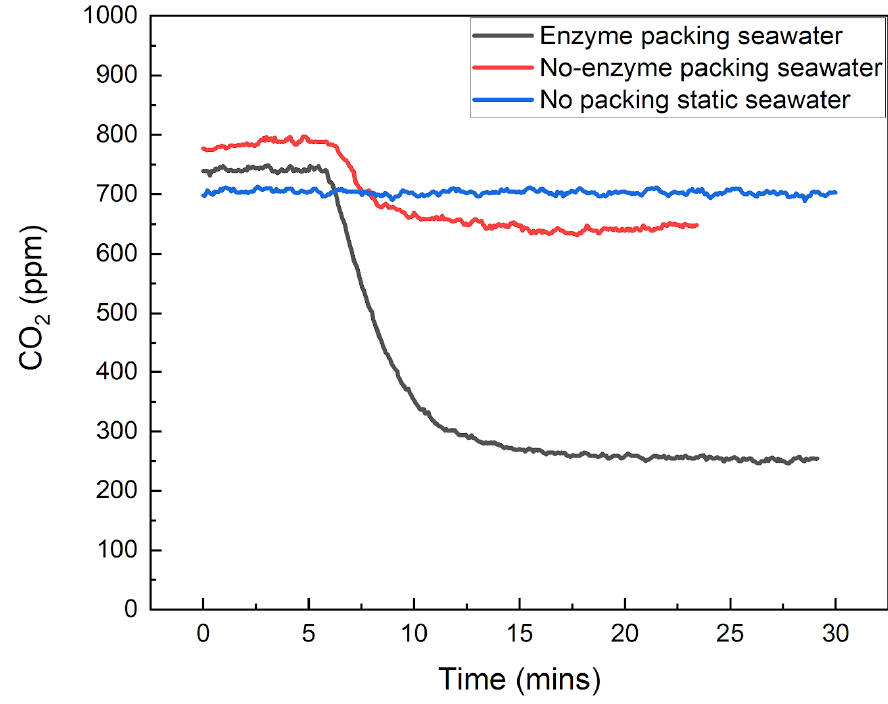
Figure 9. Lab-scale CO 2 direct air capture using simulated seawater as solvent.